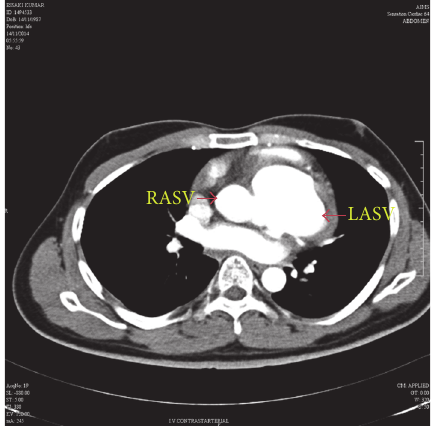
Figure 4: MDCT aortogram suggested left aneurysm of sinus of Valsalva (LASV) and right aneurysm of sinus of Valsalva (RASV) with extension into the interventricular septum.